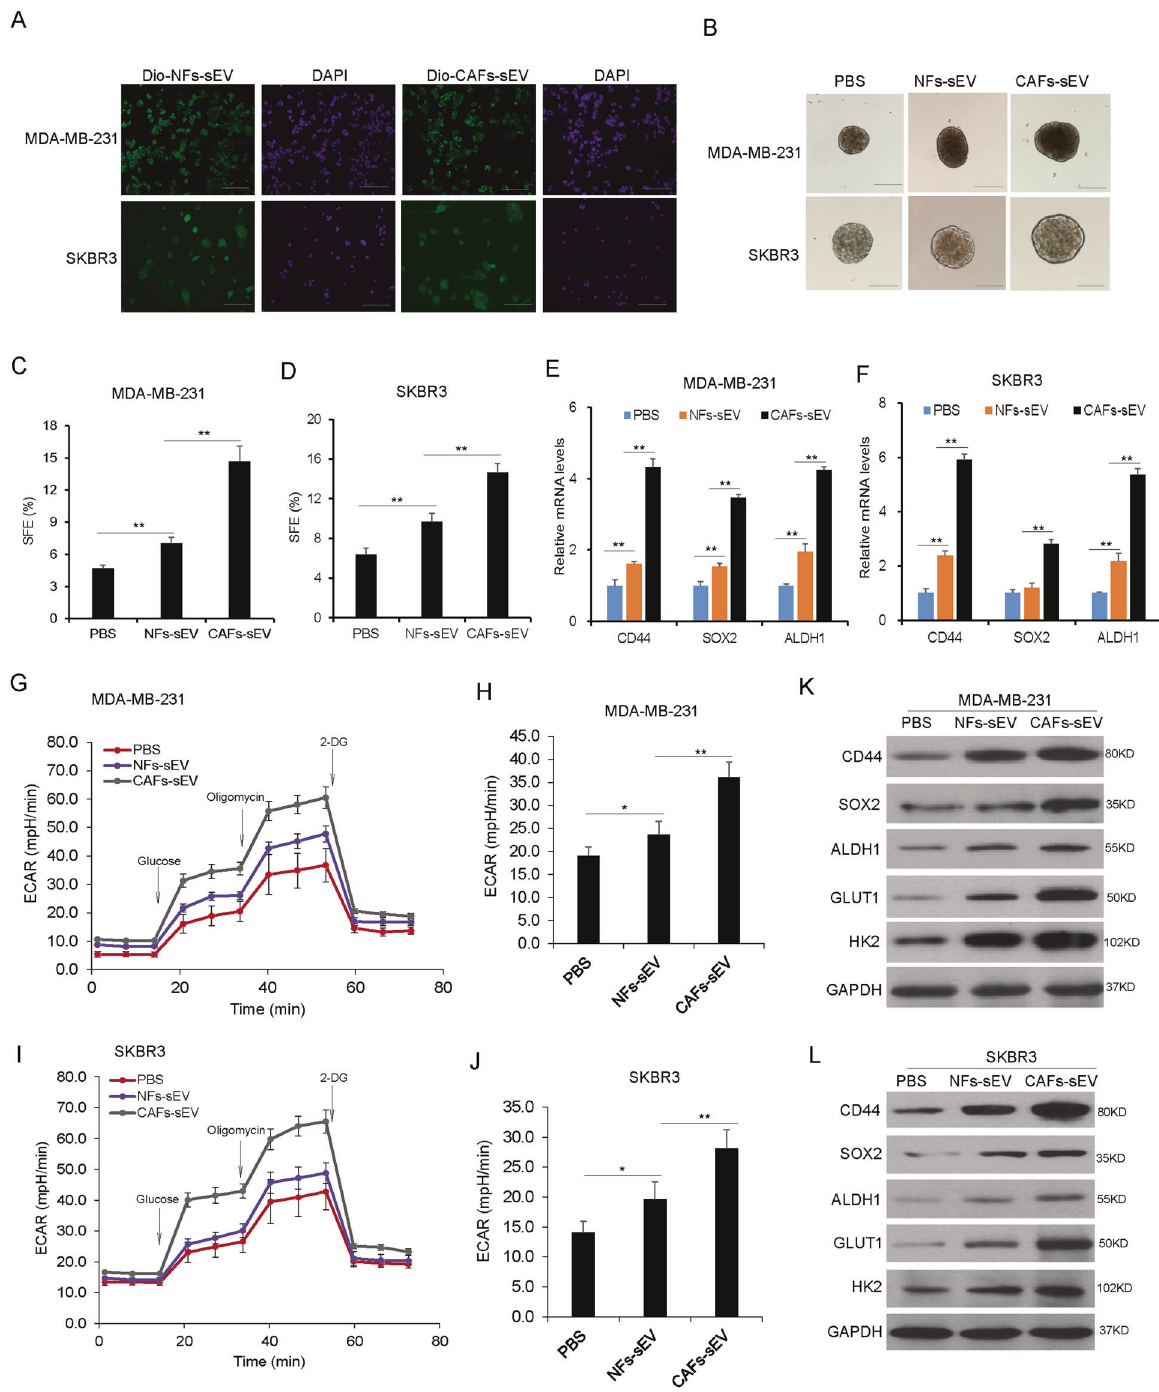
Fig. 2 The sEVs from CAFs increased the population of breast cancer stem cells and glycolysis. A MDA-MB-231 cells could uptake sEVs from CAFs or NFs. sEVs were labeled with Dio and co-cultured with the cells for 6 h and sEVs were observed under a microscope (scale bars, 100 µm). B CAFs derived sEVs increased the population of breast cancer stem cells. MDA-MB-231 and SKBR3 cells were treated with CAFs- sEV or NFs-sEV for sphere formation analysis and the spheres were observed under a microscope (scale bars, 100 µm). C , D Sphere formation rates of MDA-MB-231 and SKBR3 cells. E , F The expression of stem cell markers in MDA-MB-231 and SKBR3 cells. The total RNA was extracted from the mammospheres from breast cancer cells. The markers such as CD44, CD24, and ALDH1 were assayed by real-time RT-PCR. G Extracellular cellular acid rate (ECAR) in cancer with CAFs-sEV or NFs-sEV treatment. ECAR was measured by the Seahorse XF Cell Mito Stress Test in MDA-MB-231 cells. Measurements were performed in triplicates. H Glycolysis and glycolytic capacity analysis from ( G ). I ECAR in cancer with CAFs-sEV or NFs-sEV treatment. ECAR was measured by the Seahorse XF Cell Mito Stress Test in SKBR3 cells. Measurements were performed in triplicates. J Glycolysis and glycolytic capacity analysis from ( I ). K , L The expression of stem cell markers in breast cancer cells. MDA-MB-231 and SKBR3 cells were treated with CAFs-sEV or NFs-sEV for 48 h and total protein was extracted for western blot analysis. * p < 0.05, ** p < 0.01.